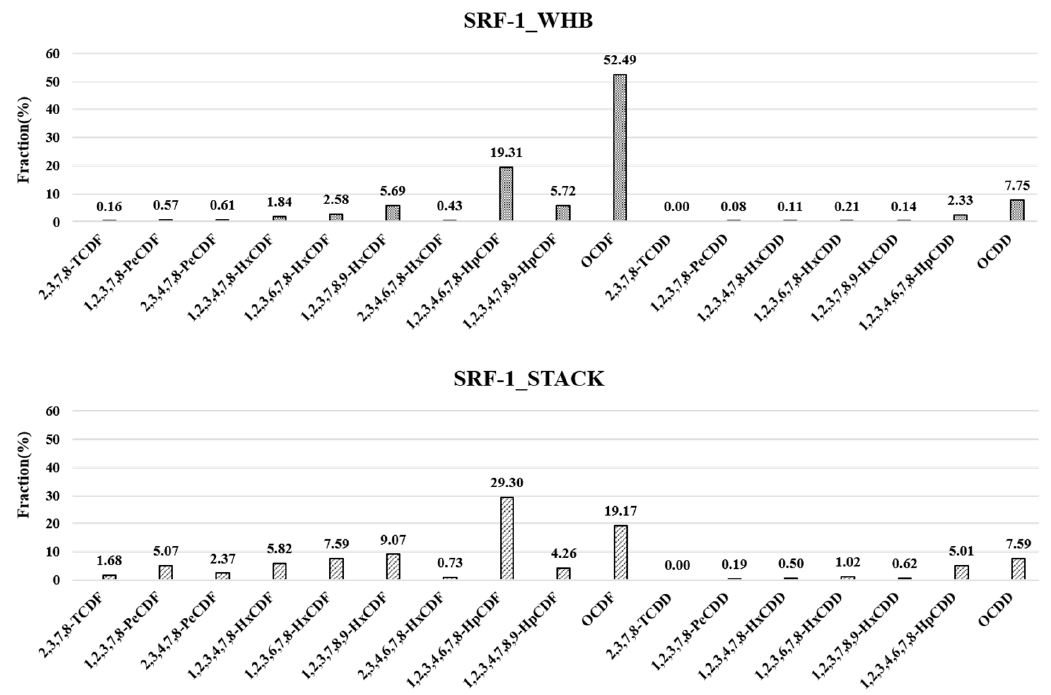
Figure 6. PCDD/DFs congener pattern in an SRF-1 incineration plant.